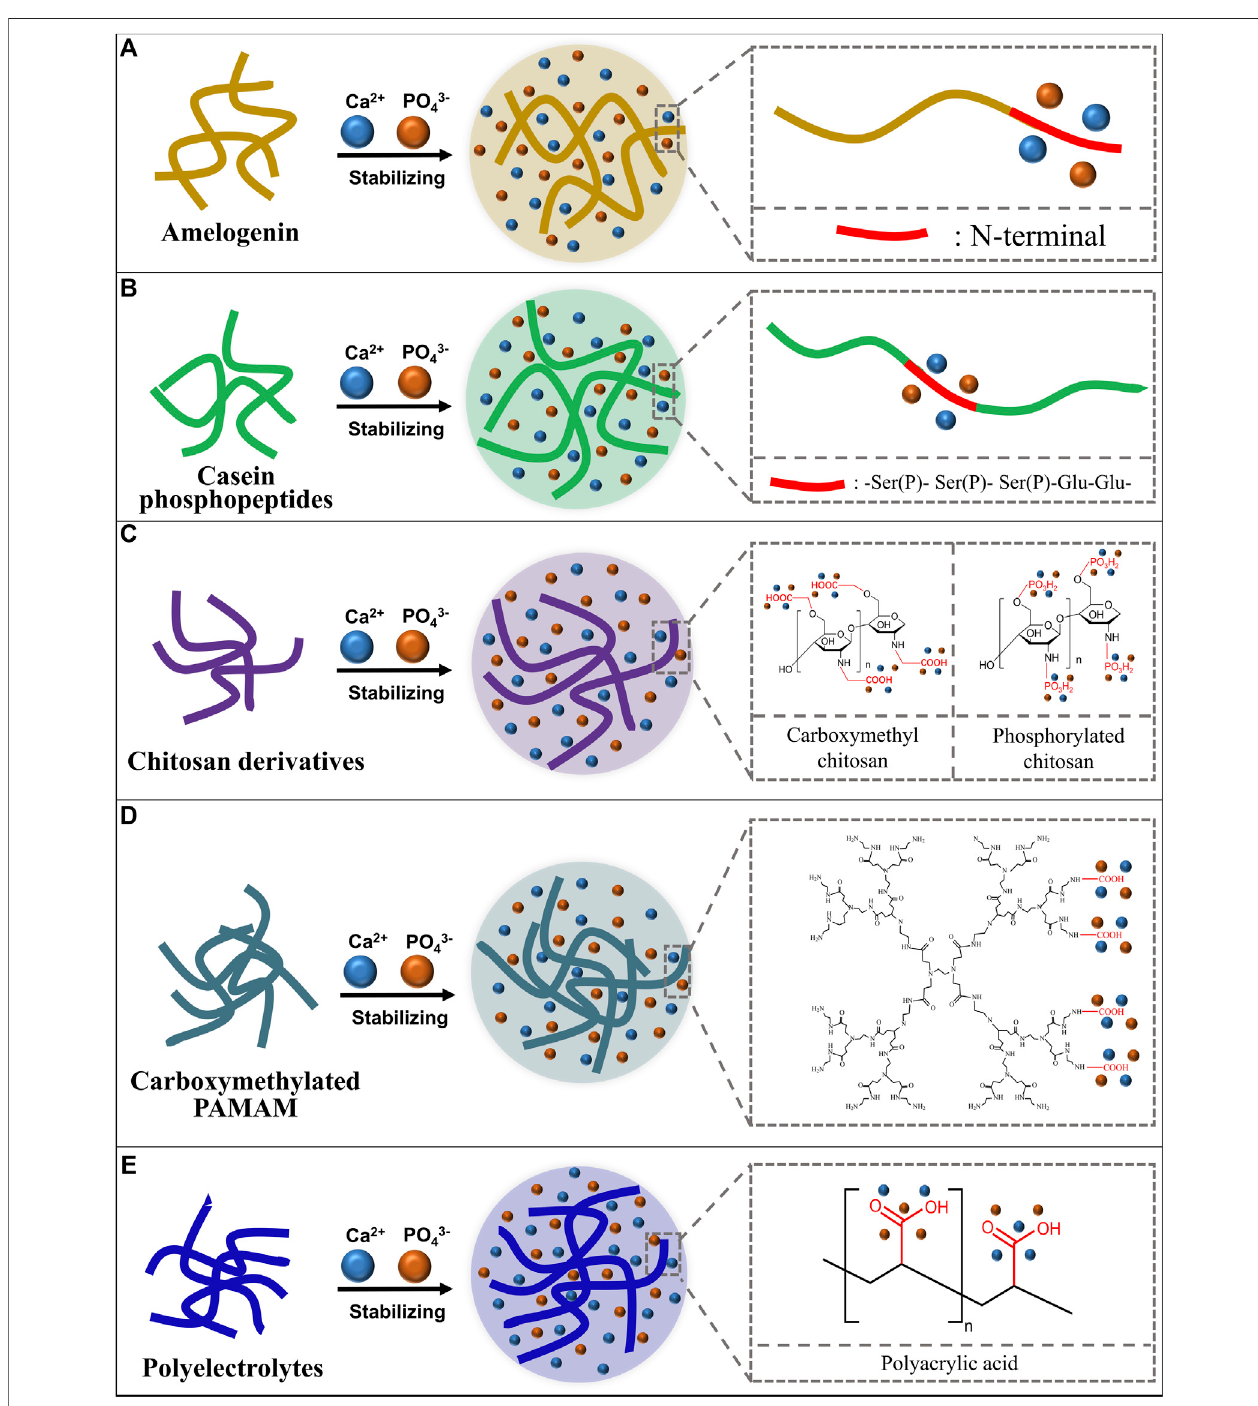
FIGURE 1 | Schematic diagram of ACP stabilizers and how they stabilize the ACP. (A) Amelogenin stabilizes calcium and phosphorus ions with its N-terminal; (B) Casein phosphopeptides stabilize calcium and phosphorus ions with the -Ser(P)- Ser(P)- Ser(P)-Glu-Glu- sequence; (C) Chitosan derivatives stabilize calcium and phosphorus ions with functional groups; (D) Carboxymethylated poly-amidoamine (PAMAM) stabilizes calcium and phosphorus ions with carboxyl groups; (E) Polyelectrolytes stabilize calcium and phosphorus ions with functional groups.